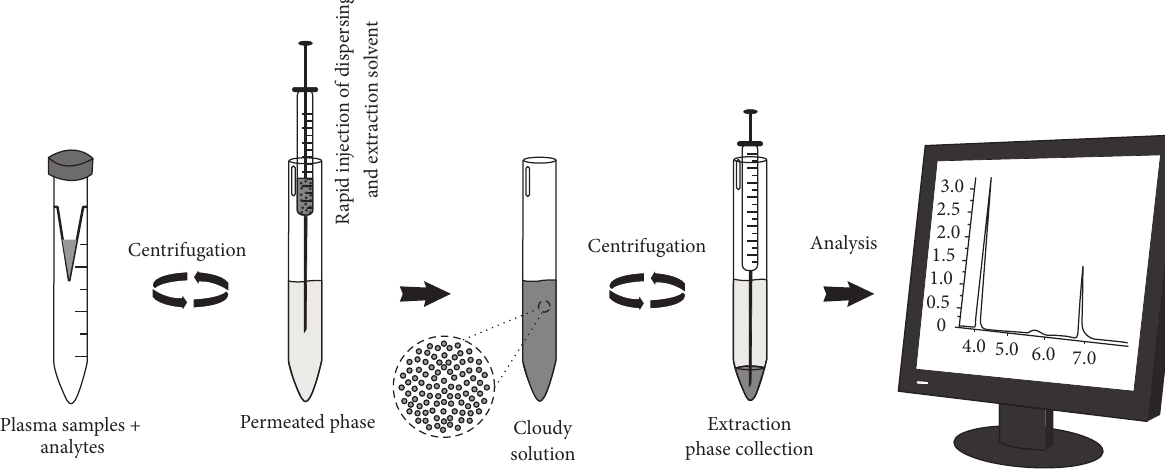
Figure 2: Steps of DLLME